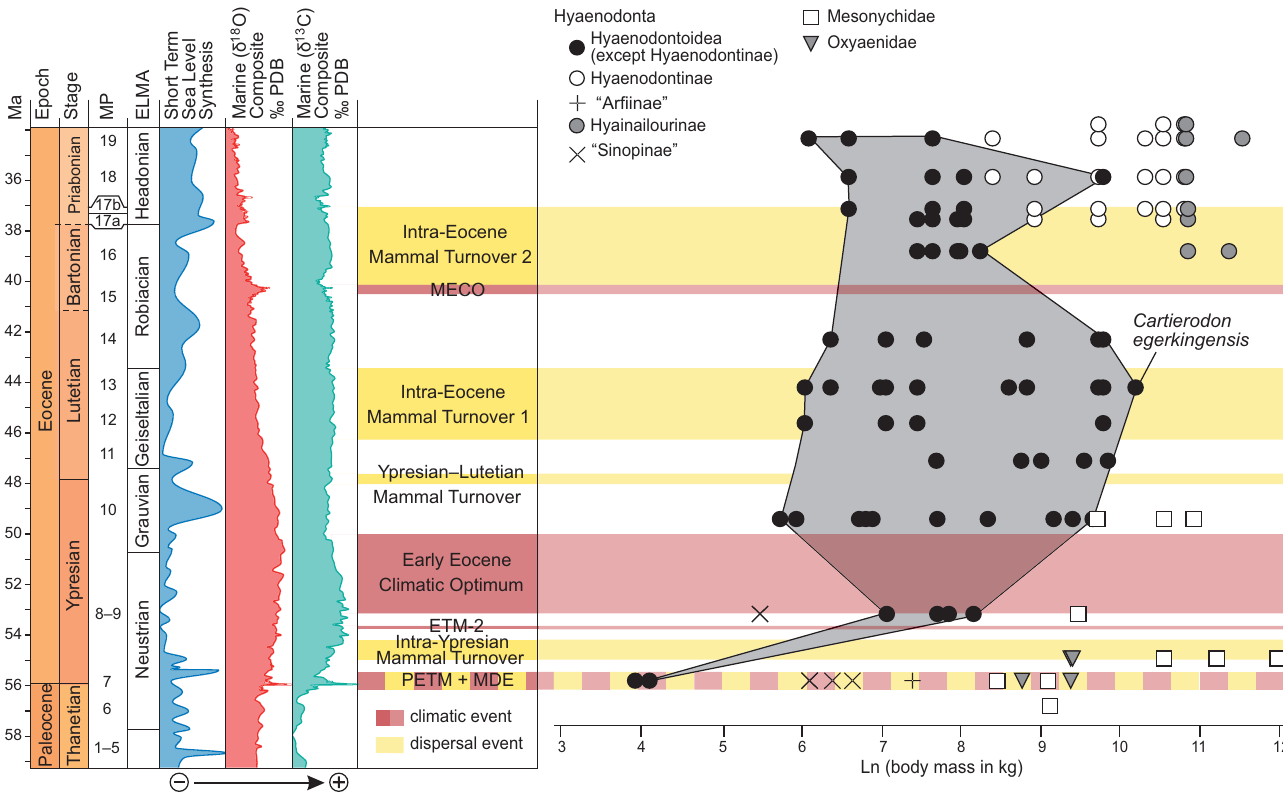
Fig. 7. Values of the body mass (in ln) of oxyaenids, mesonychids, and hyaenodonts (Hyaenodontoidea, “Sinopinae”, “Arfiinae”, Hyainailourinae, and Hyaenodontinae) from MP7 to MP19 with particular attention on the new species from Egerkingen γ (Hyaenodontinae + “Arfiinae”). Values from Table 1 ( Cartierodon egerkingensis gen. et sp. nov.) and Solé et al. (2015). Egerkingen γ is here represented to be close to the MP13 reference-level. Abbreviations: ELMA, European Land Mammal Ages; ETM-2, Eocene Thermal Maximum 2; MECO, Middle Eocene Climatic Optimum; MDE, Mammal Dispersal Event; MP, Mammal Palaeogene; PETM, Paleocene–Eocene Thermal